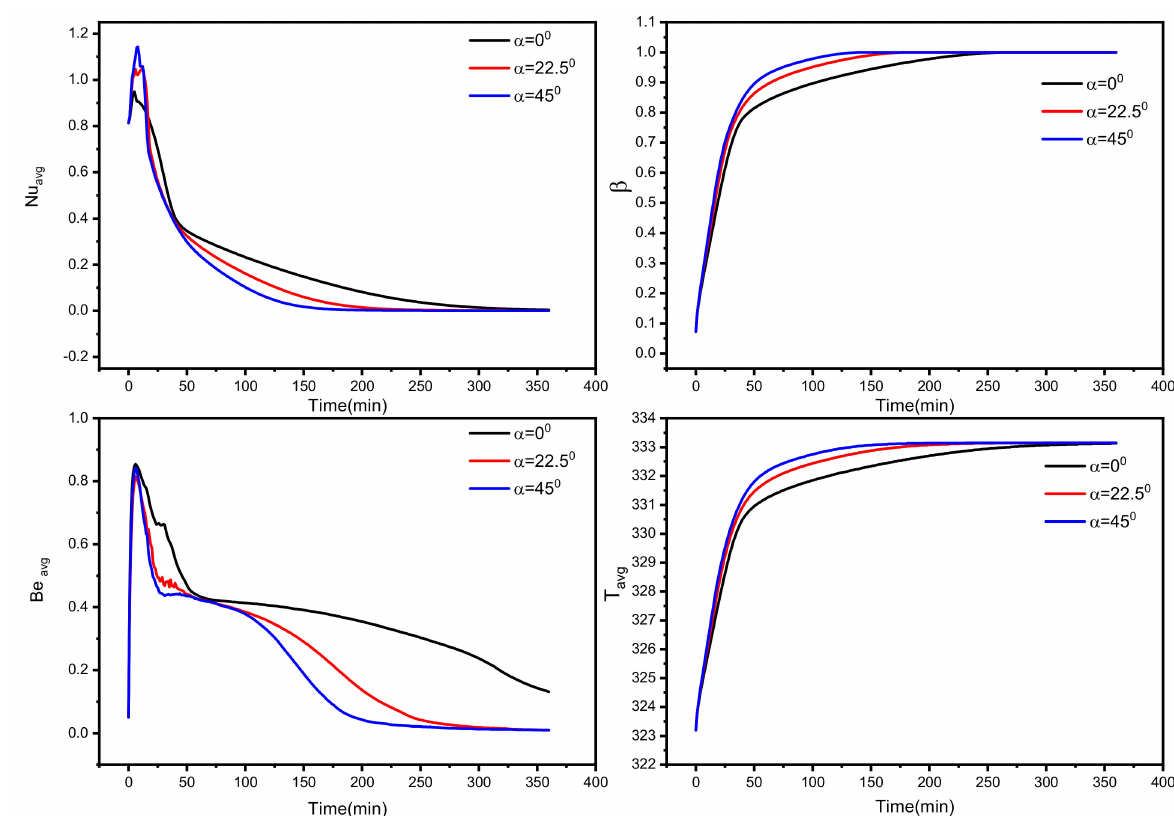
Figure 10. Temporal effect of tube position (inclination angle) on the investigated tube–shell TES performance in terms of average Nusselt number, liquid fraction, average Bejan number, and average PCM